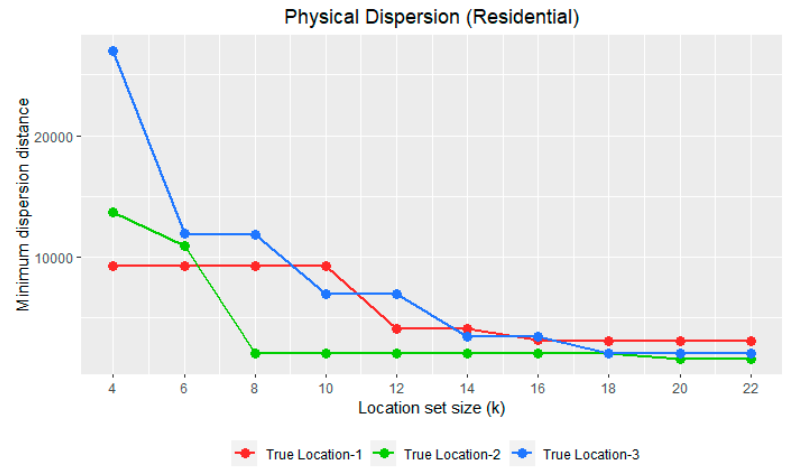
Figure 6. Plots show physical dispersion of residential locations in a location set with the size of